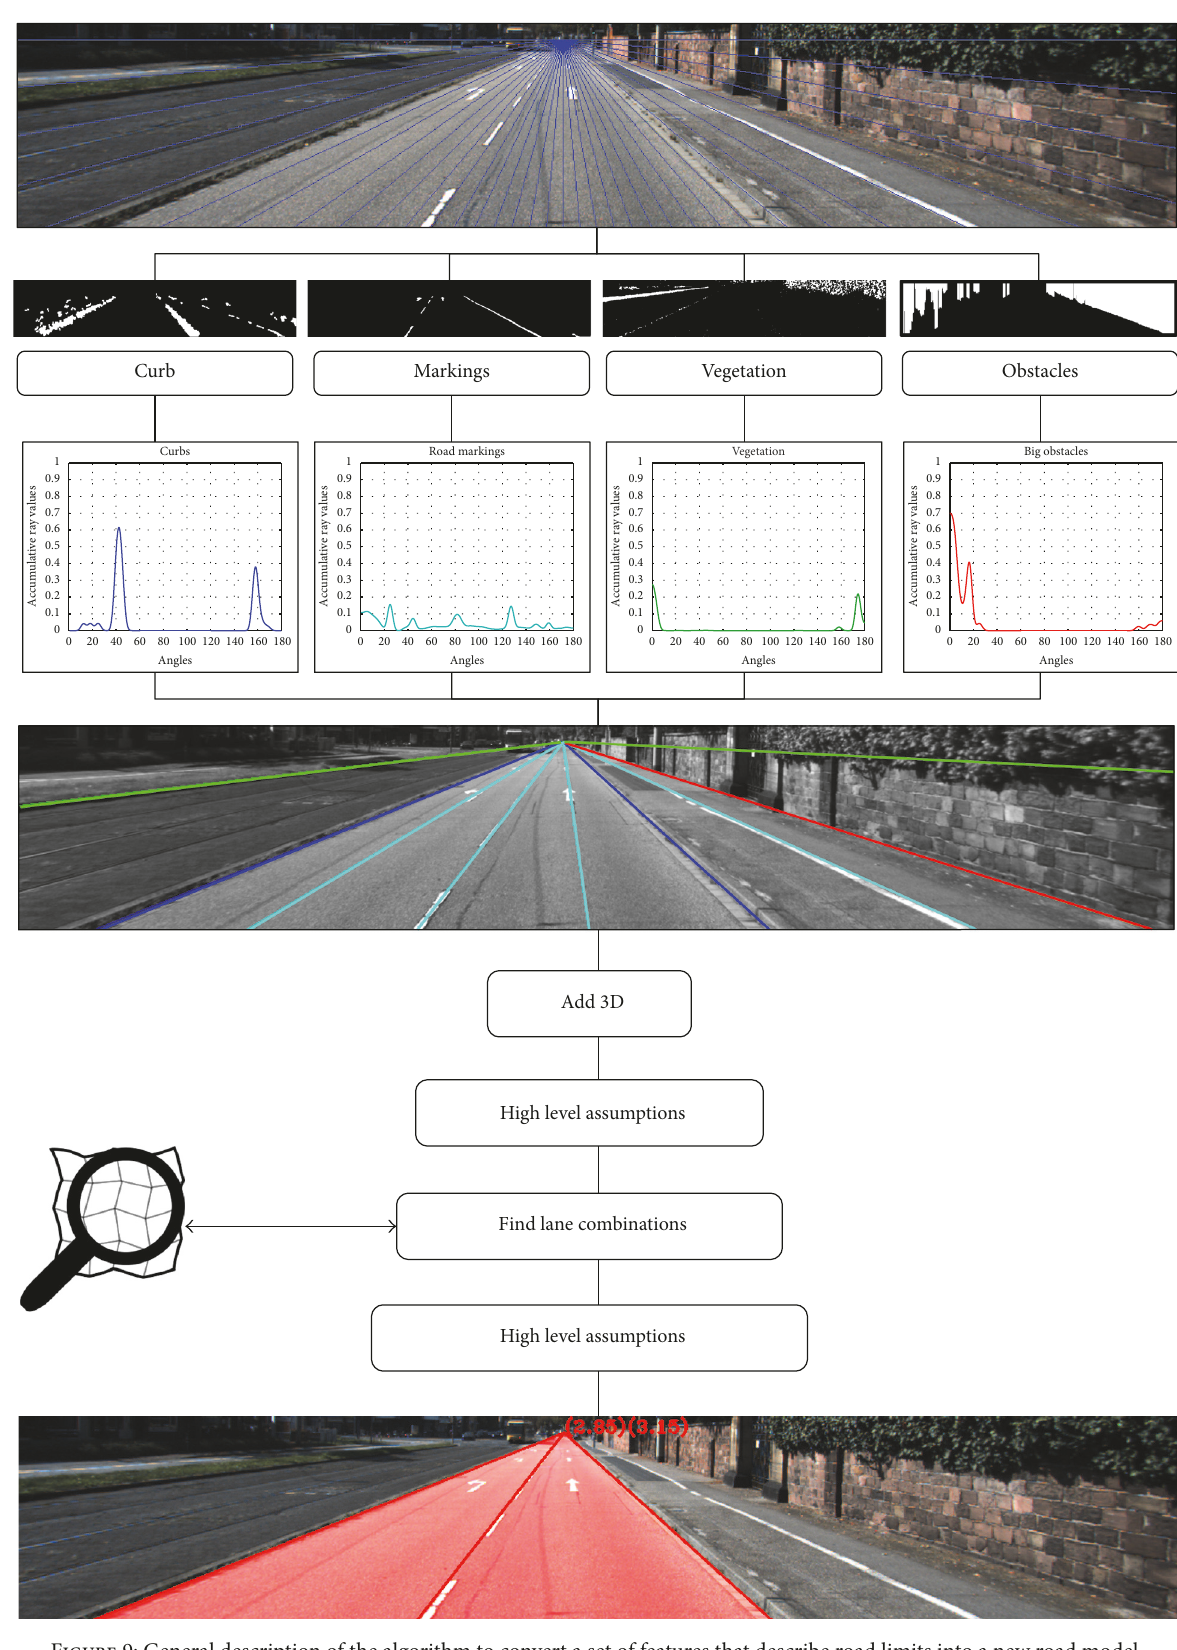
Figure 9: General description of the algorithm to convert a set of features that describe road limits into a new road